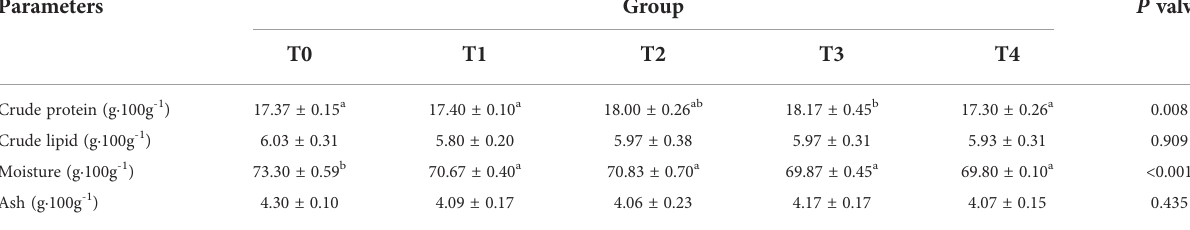
TABLE 5 Effect of dietary taurine level on organism composition of T. ovatus.